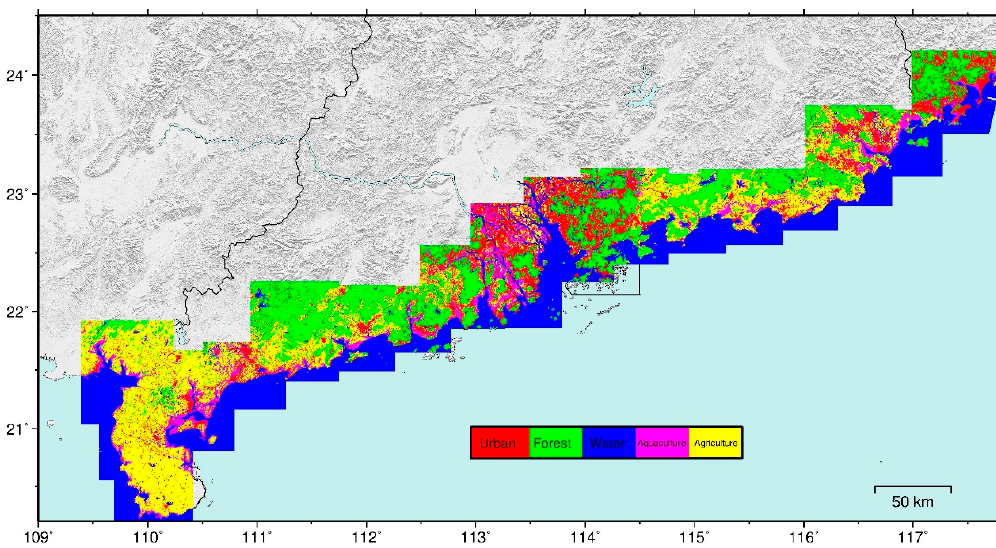
Figure 7. Land-use classification map. The red, green, blue, purple and yellow shading represent urban, forest, water, aquaculture and agricultural land